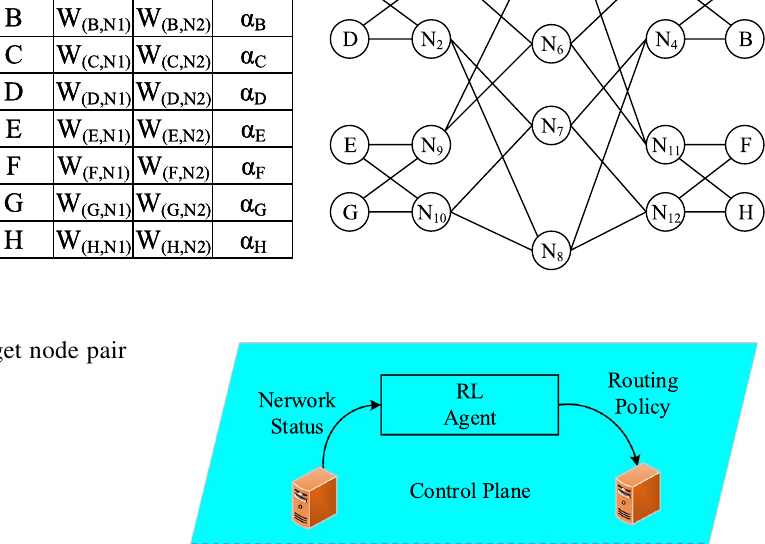
Fig. 3 Diversion ratio table of source node A